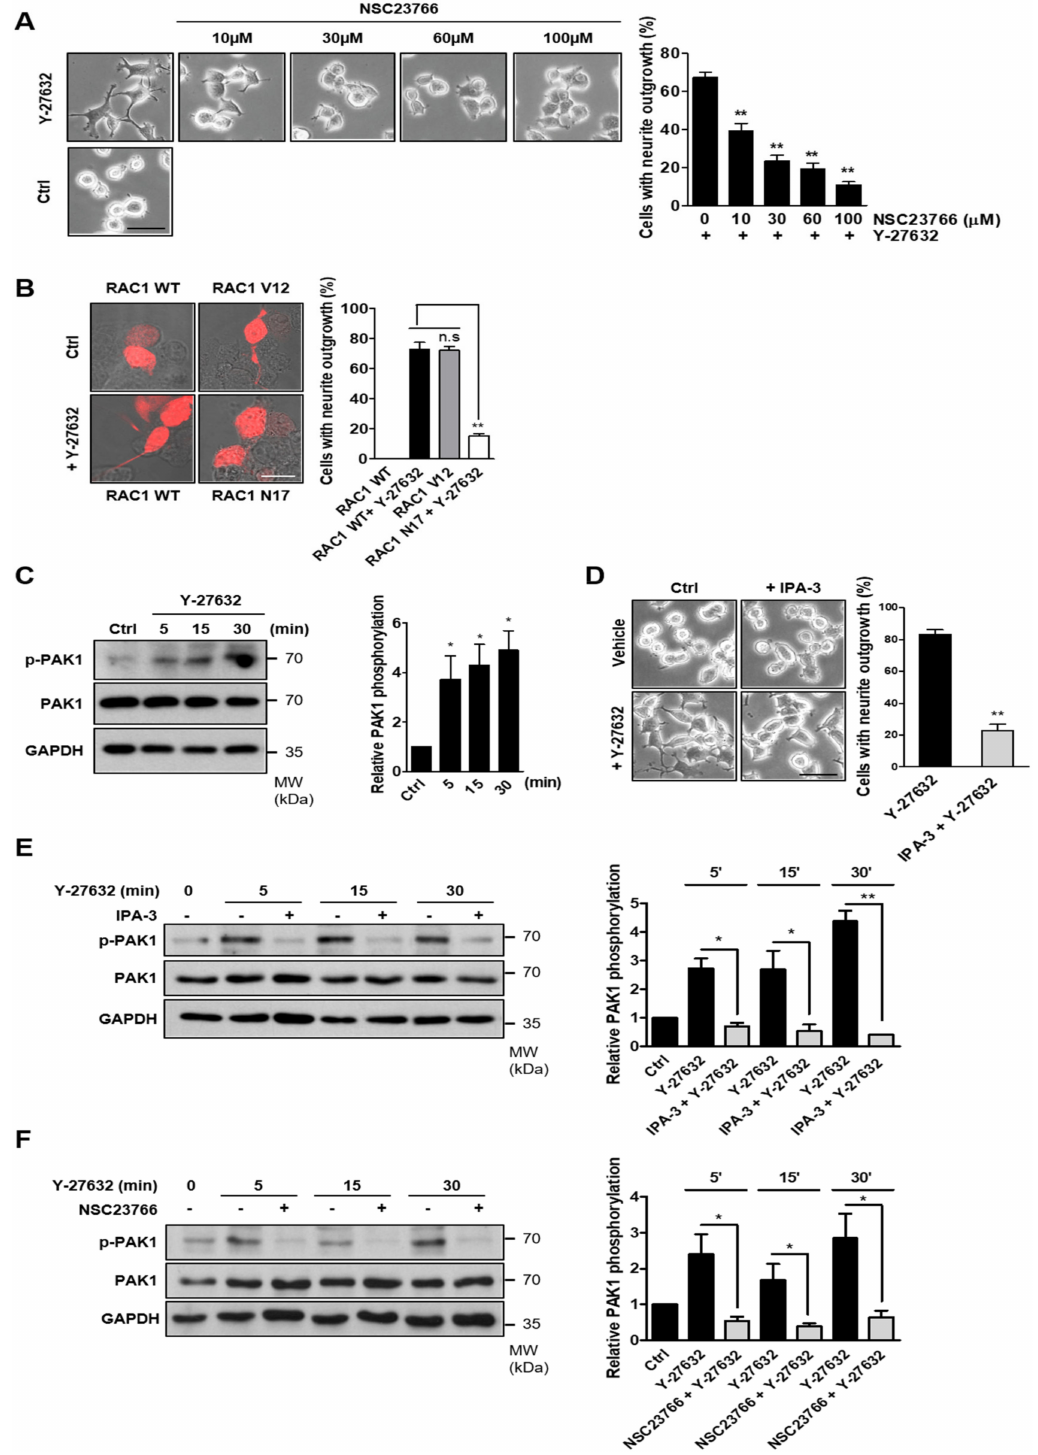
Figure 3. Activation of the Rac1-PAK1 cascade results in neurite outgrowth in PC12 cells. ( A ) PC12 cells were pretreated with di ff erent concentrations of NSC23766 (10, 30, 60, or 100 µ M), a selective inhibitor of the Rac1-GEF interaction, for 30 min and then exposed to 25 µ M Y-27632 for 2 h. Cells were counted by determining the percentage of cells bearing neurites among the total cells. Note that Y-27632-induced neurite outgrowth was inhibited by the Rac1 inhibitor NSC23766 in a dose-dependent manner. Scale bar = 50 µ m. Culture images are at a magnification of 20 × . ( B ) PC12 cells were incubated with the indicated plasmids (Rac1 WT; wild-type Rac1, Rac1 V12; a constitutively active form of Rac1 or Rac1 N17; a dominant negative form of Rac1) for 24 h. Cells were then exposed to 25 µ M Y-27632